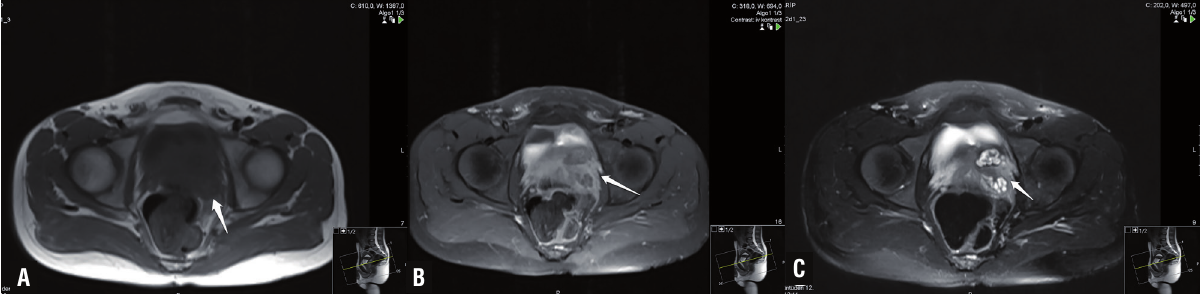
Figure 2 - Mri axial images; nodular lesions marked with arrows. a. t1 weighted B. post contrast t1 weighted fat suppressed c. t2 weighted fat suppressed